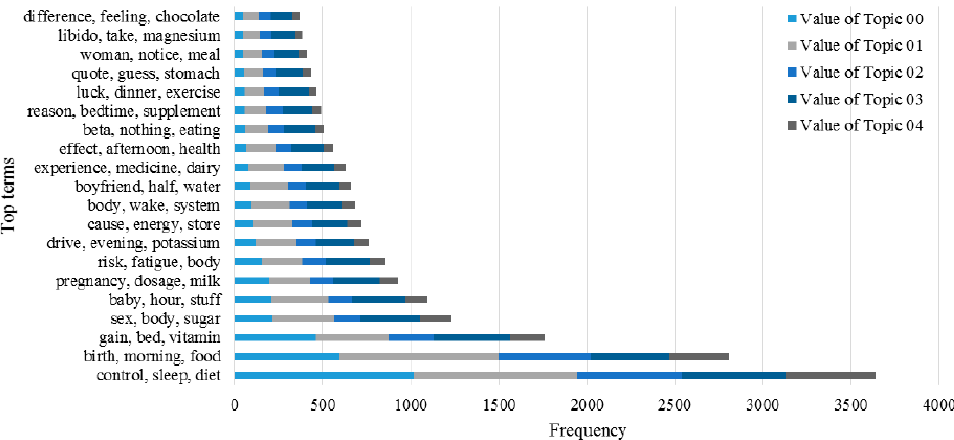
Figure 7. Comparison of frequency values of five topics with top five terms by using Knowledge-Involved Topic Modeling (KI-TM) with Latent Knowledge Rate ( LKR ) ( m = 1).